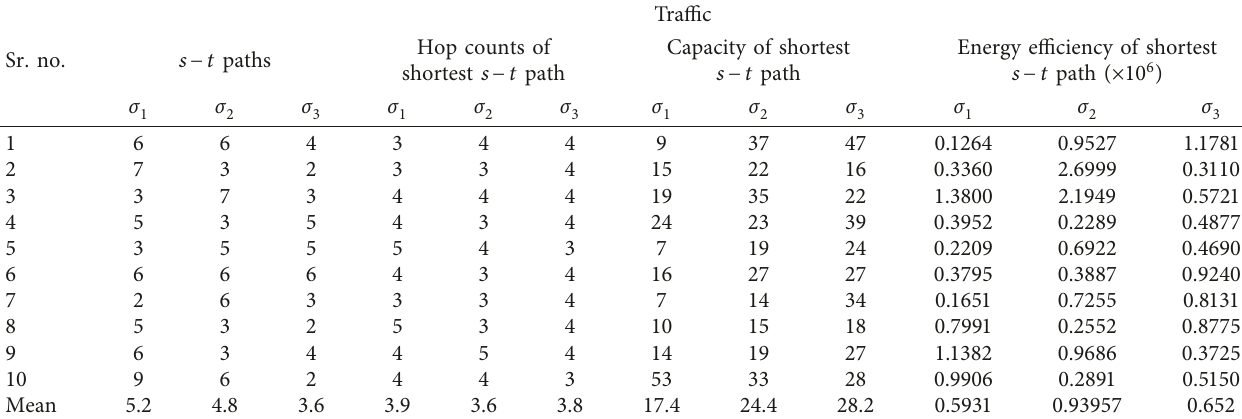
Table 2: Number of s − t paths, hop counts, capacity, and energy efficiency of the shortest s − t path. Sr.